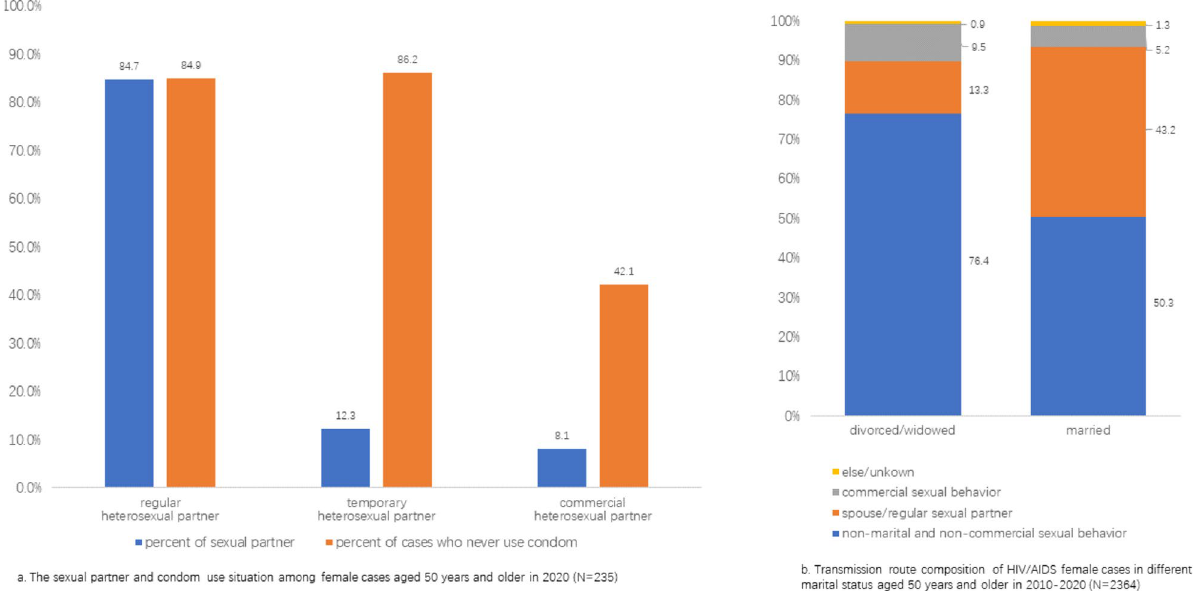
Figure 3. Sexual behavior of female cases aged 50 years and older and the composition of transmission